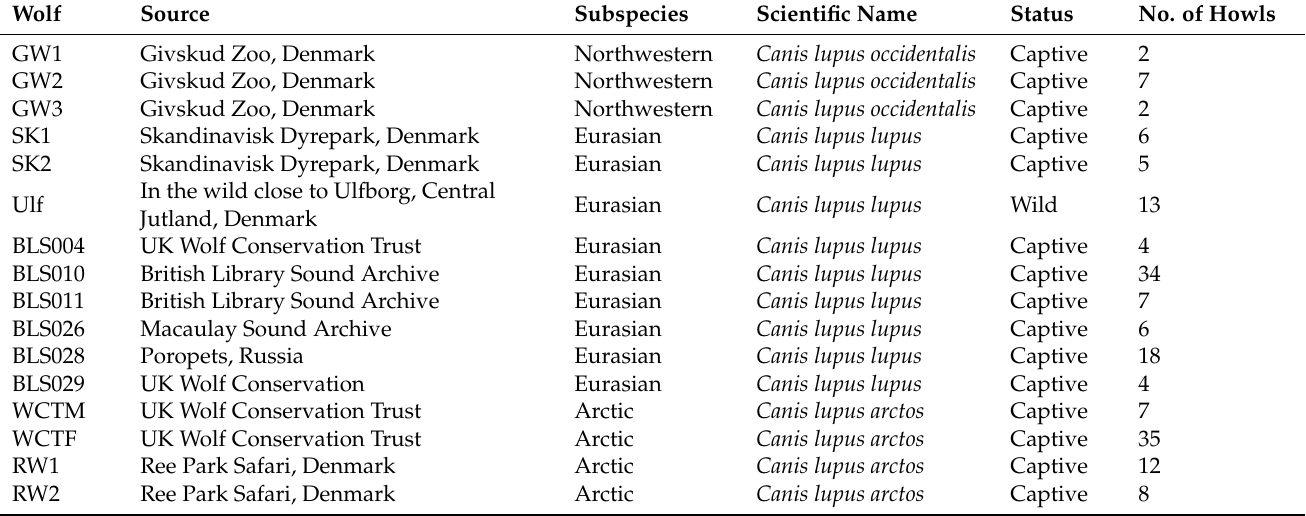
Table 1. Wolves included in the individual identification with source for recordings, subspecies, and number of